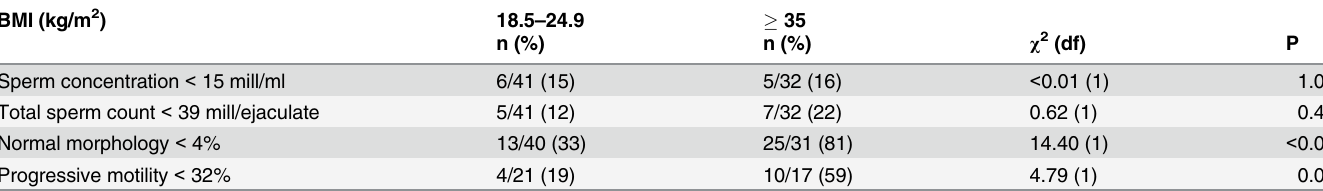
Table 3. Proportions of normal weight and severely obese men with semen parameters below the WHO lower reference limits [38].